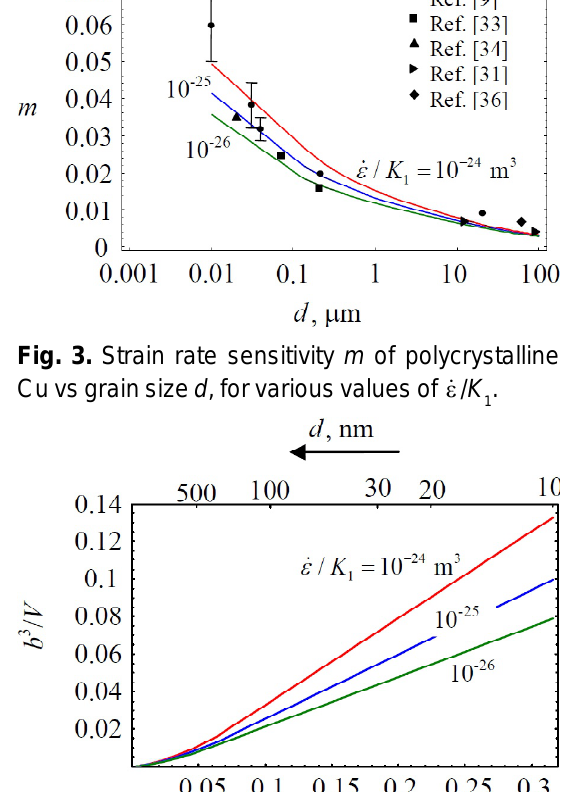
Fig. 4. Dependences of the normalized inverse ac- tivation volume b 3 / V of polycrystalline Cu on the in- verse square root, d -1/2 , of grain size d , for various values of   / K 1